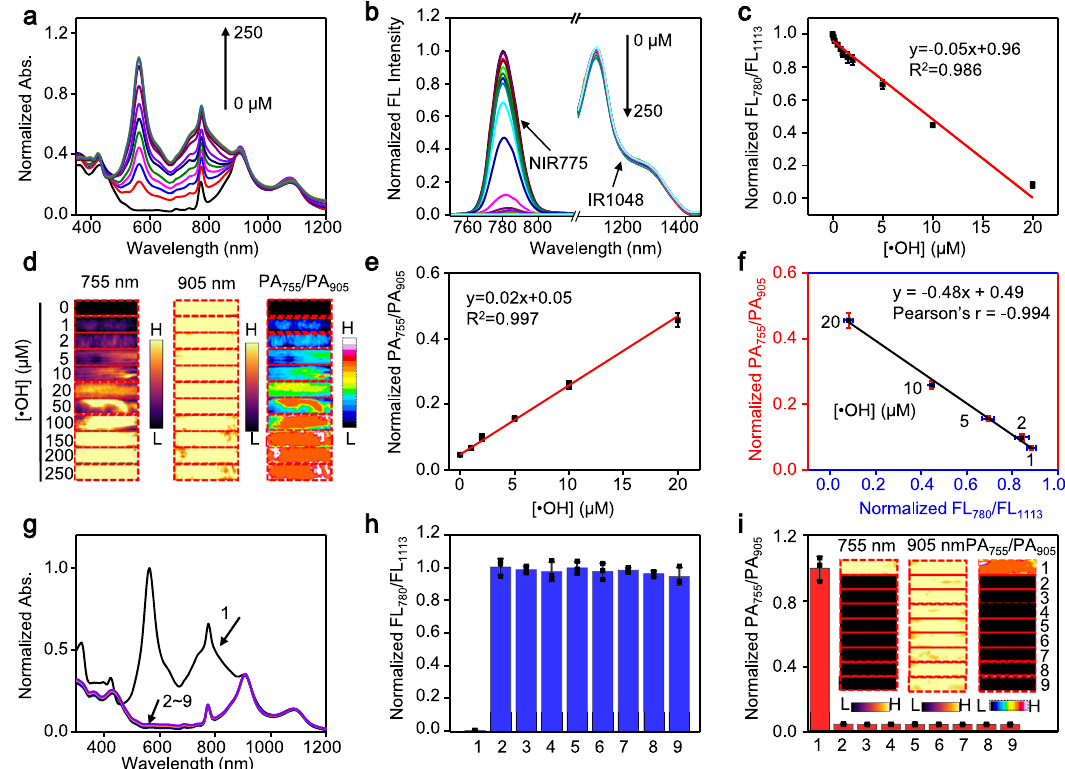
Fig. 3 Measurement of (cid:129) OH by 1-NP in vitro. a Normalized absorption and b nomalied fl uorescence (FL) spectra of 1-NP upon incubation with different concentration (cid:129) OH (0, 1, 2, 5, 10, 20, 50, 100, 150, 200, 250 μ M Fe 2 + + 1 mM H 2 O 2 ) at r.t. for 3 min. c Plot of the normalized FL 780 /FL 1113 values versus the concentration of (cid:129) OH show a linear relationship ranging from 0.05-20 μ M of (cid:129) OH. The limit of detection (LOD) was determined to be ~3.69 nM by using the 3 δ /k method. d Photoacoustic (PA) images at 755 and 905 nm, and ratiometric PA 755 /PA 905 images of 1-NP (56/1.65/20 μΜ 1-Br-Et/NIR775/ IR1048) upon incubation with the indicated concentration of (cid:129) OH at r.t. for 3 min. e Plot of the normalized PA 755 /PA 905 values versus the concentration of (cid:129) OH show a linear relationship between 1 and 20 μ M of (cid:129) OH. The LOD was determined to be ~0.24 μ M by using the 3 δ /k method. f Plot of the normalized PA 755 /PA 905 ratios versus the normalized FL 780 /FL 1113 ratios shows a strong correlation (Pearson ’ s r = − 0.994) between them upon incubation of 1-NP with the indicated concentration of (cid:129) OH. g Normalized UV-Vis-NIR absorption spectra, h normalized FL 780 /FL 1113 values and i normalized PA 755 /PA 905 values of 1-NP after incubation with (cid:129) OH and other representative reactive oxygen species (ROS) at r.t. for 24 h. Inset: PA images at 755 nm and 905 nm, and ratiometric PA 755 /PA 905 images of 1-NP following indicated treatment. 1: (cid:129) OH (200 µ M Fe 2 + + 1 mM H 2 O 2 ); 2: 1 O 2 (1 mM H 2 O 2 + 1 mM ClO − ); 3: 300 µ M t-BuOOH; 4: 1 mM ClO − ; 5: 300 µ M CuOOH; 6: 1 mM H 2 O 2 ; 7: O 2 ·- (100 µ M xanthine + 22 mU xanthine oxidase (XO)); 8: ONOO − (1 mM NaNO 2 + 1 mM H 2 O 2 ); 9: Control. Data are presented as mean ± s.d. ( n = 3 independent samples). Source data are provided as a Source Data fi